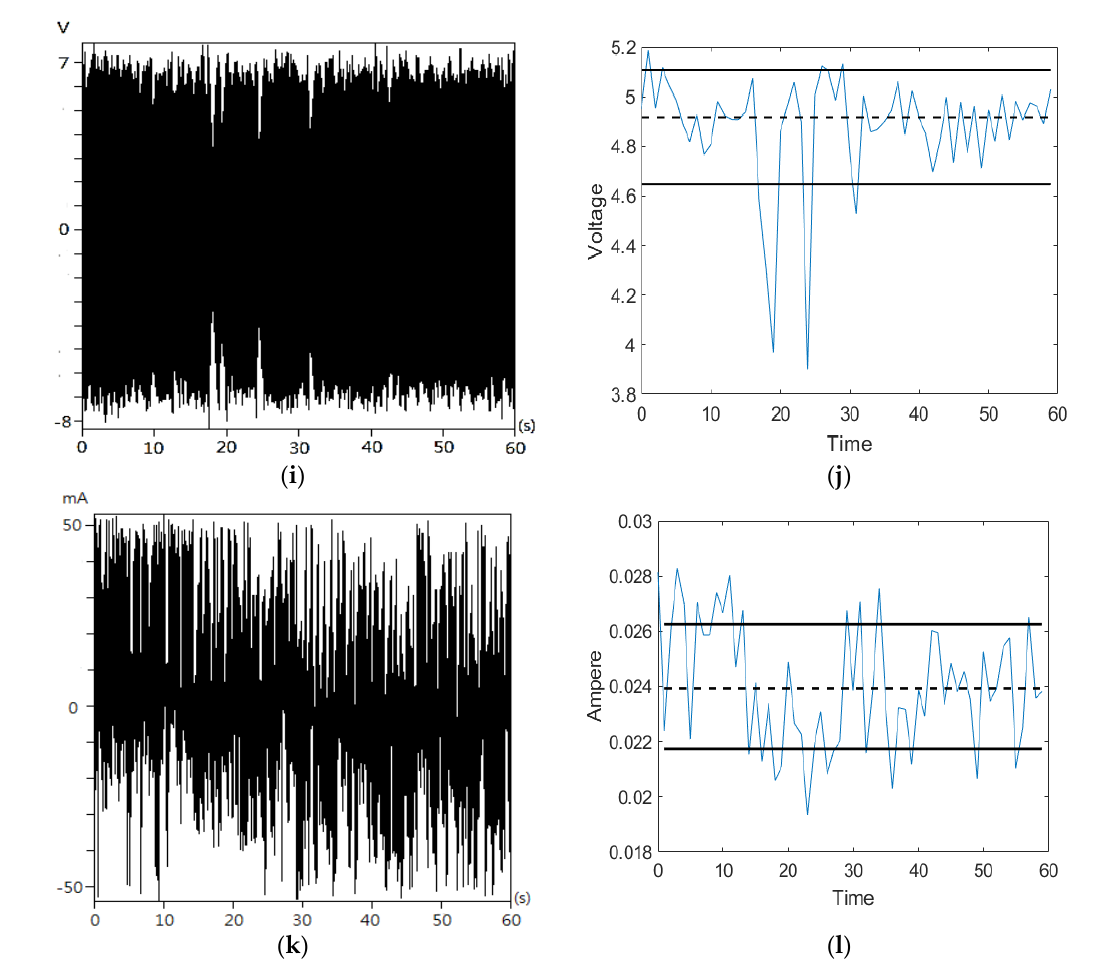
Figure 9. Experimental power benefit data of DESS system. ( a ) 1st mode voltage, ( b ) 1st mode RMS voltage, ( c ) 1st mode ampere, ( d ) 1st mode RMS ampere, ( e ) 2nd mode voltage, ( f ) 2nd mode RMS voltage, ( g ) 2nd mode ampere, ( h ) 2nd mode RMS ampere, ( i ) 3rd mode voltage, ( j ) 3rd mode RMS voltage, ( k ) 3rd mode ampere, ( l ) 3rd mode RMS ampere.